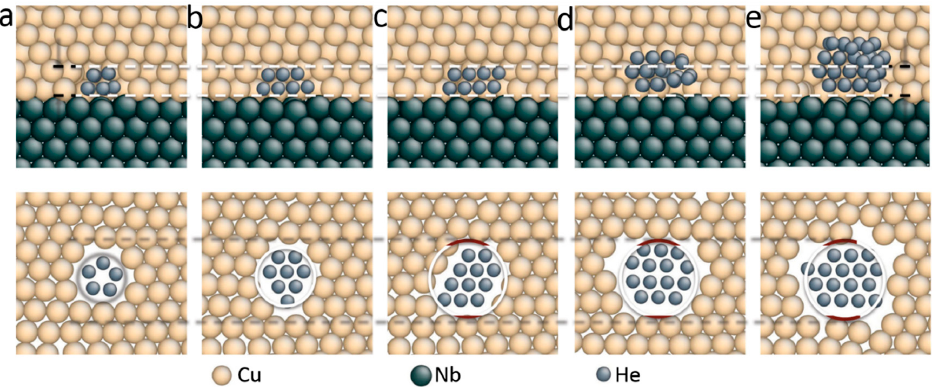
Figure 14. The evolution process of He cluster along Cu/Nb interface: ( a – c ) He platelet is formed by wetting high-energy interface regions and extends along the interface; and ( d , e ) He platelet transforms into He bubble by adding a new layer of He and keeps its area along the interface constant. Reprinted with permission from [96]; Copyright 2013 NLM.